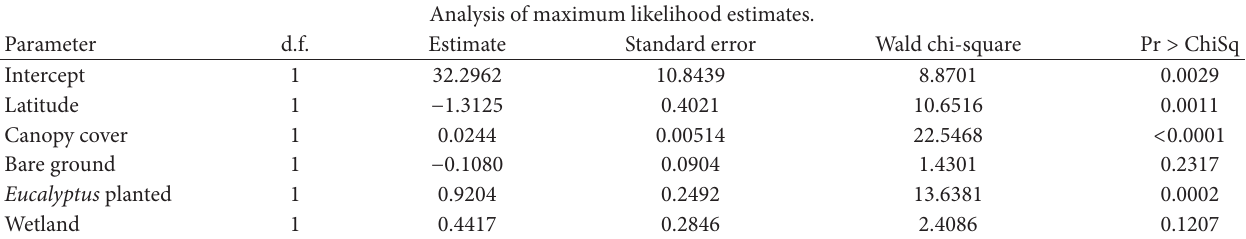
T 3: Results of logistic regression analysis of continuous (latitude, canopy cover, and percent bare ground), and binary (wetland, Eucalyptus planted previous or present) variables from the sampling survey. Canopy cover and percent bare ground data for one South Carolina site were not collected and so this site was excluded from the